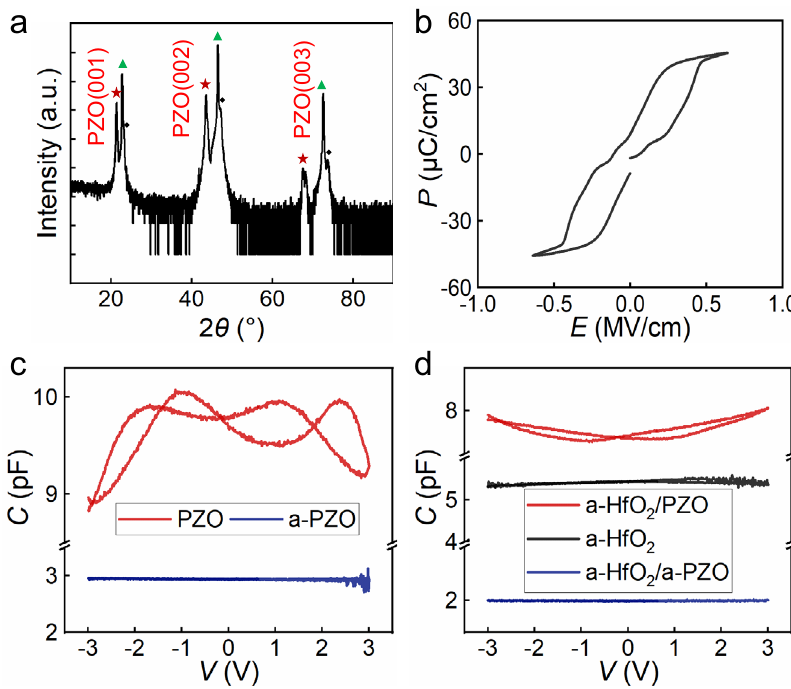
Fig. 1 Capacitance enhancement induced by the static NC effect at room temperature. a XRD data of the PZO fi lm with the orthorhombic phase deposited on the LSMO bottom electrode with STO substrate. The peaks marked by green triangles represent the STO phase and the peaks marked by black dots represent the LSMO phase. The red stars represent the (00 l ) orientation in pseudocubic index of the PZO fi lms. b Antiferroelectric polarization P as a function of the electric fi eld E ( P – E ). c Small signal capacitance – voltage ( C – V ) characteristics measured at 100 kHz for the Pt/PZO/LSMO capacitor and Pt/a-PZO/LSMO capacitor. d Comparison of C – V characteristics of Pt/a-HfO 2 /PZO/LSMO, Pt/a-HfO 2 /a-PZO/LSMO, and Pt/a-HfO 2 /LSMO